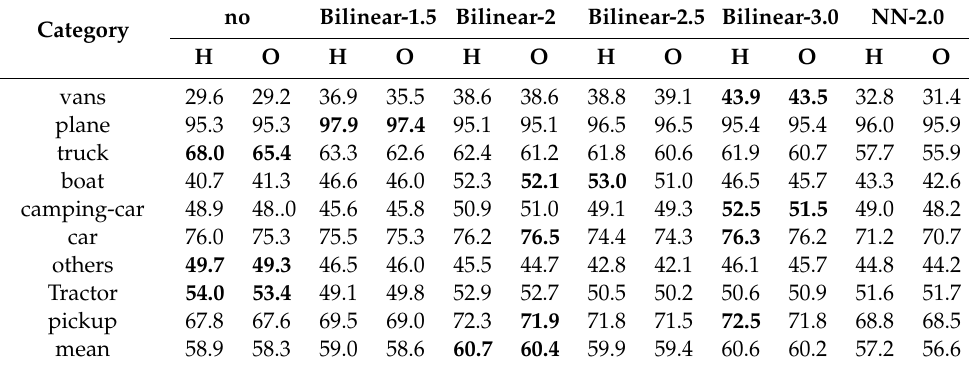
Table 11. Detection accuracy of di ff erent parameters in the feature